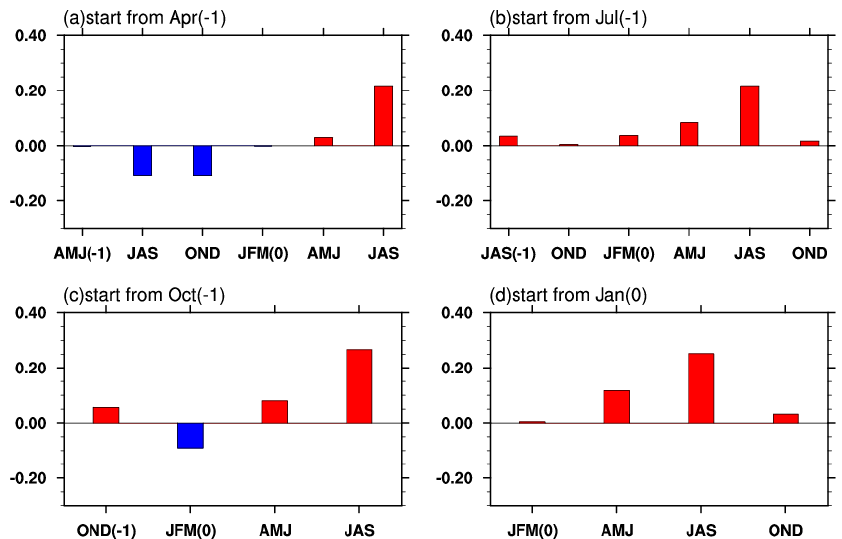
Figure 8. Seasonal mean of latent heat flux over the east pole of IOD with the start months being ( a ) April ( − 1), ( b ) July ( − 1), ( c ) October ( − 1) and ( d ) January (0).